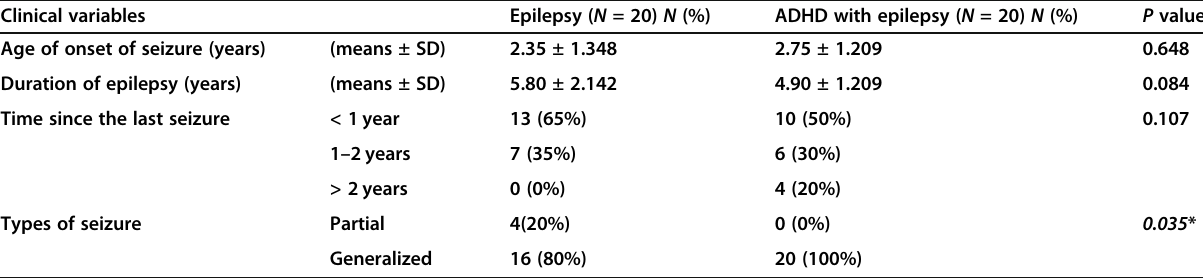
Table 2 Clinical features among epilepsy groups Clinical